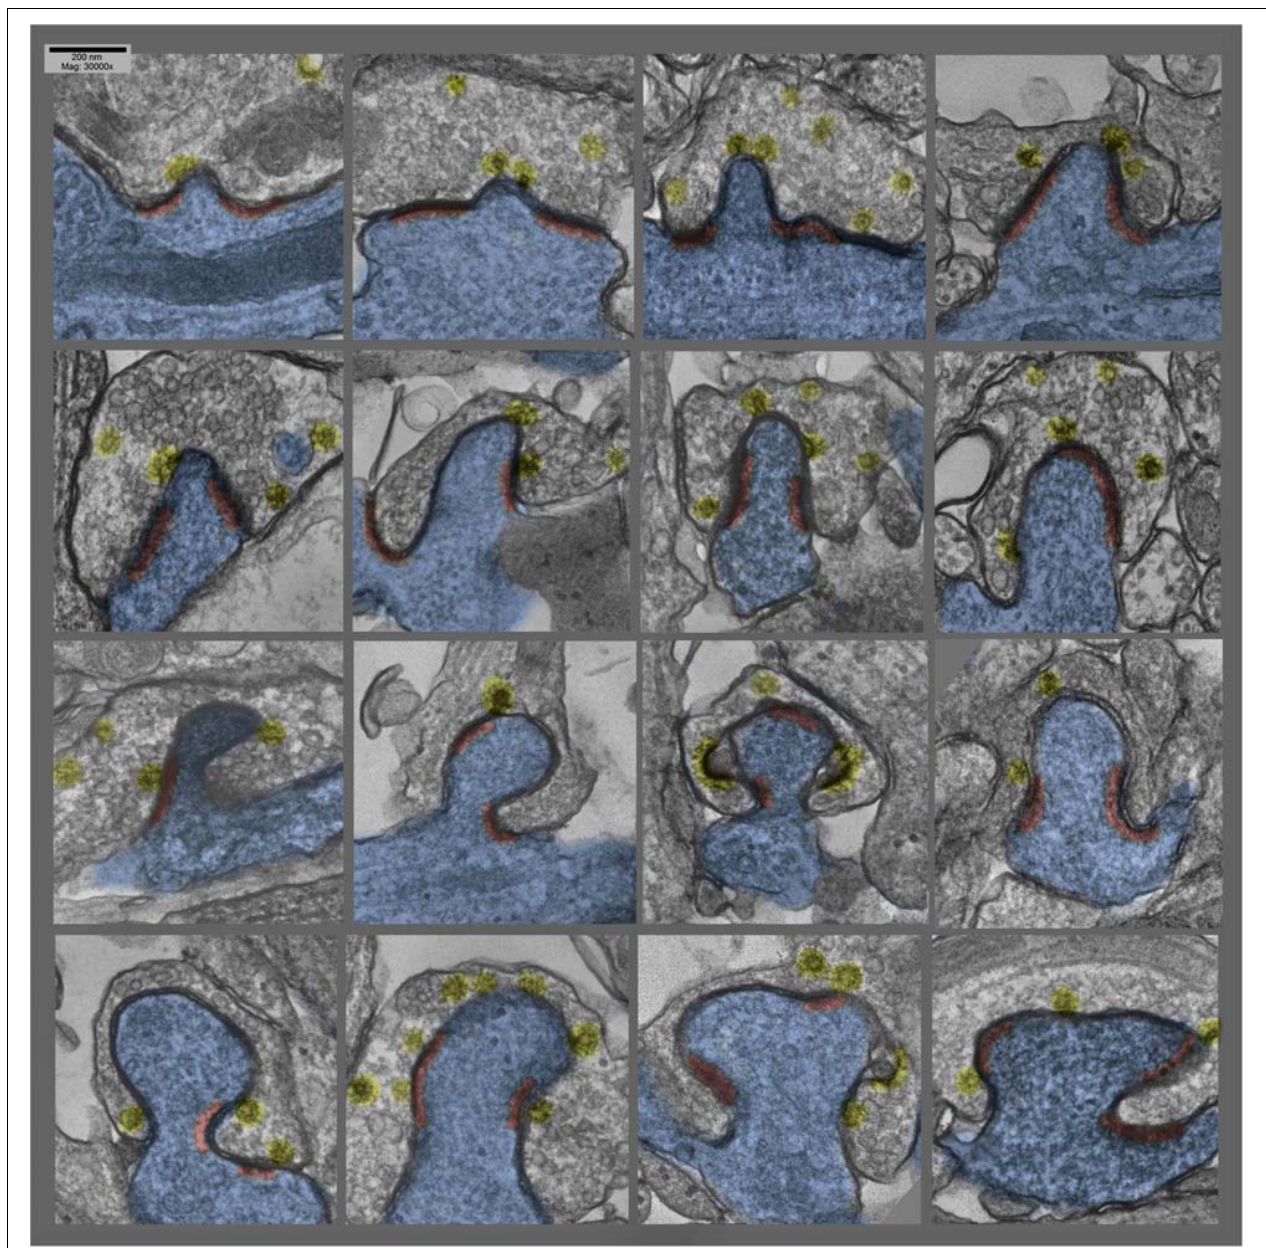
FIGURE 3 | Montage of several different postsynaptic “protrusions” (or presynaptic “hugs,” depending on one’s vantage point) in hippocampal cultures exposed to 0.1 mM La +++ for 10–20 min at 37 ◦ C. Synaptic vesicles are more or less depleted, and clathrin-coated vesicles (again highlighted in yellow) are relatively abundant, and PSDs (highlighted in red) are hanging back or are fragmented and “holding on” to the edges of the postsynaptic